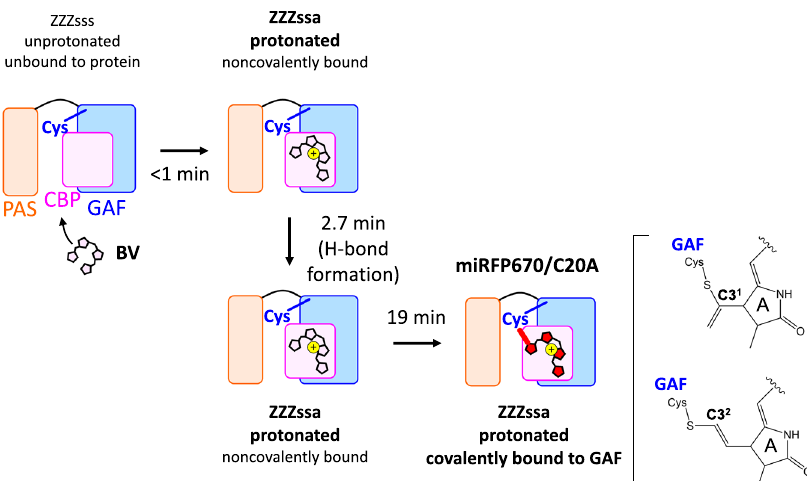
Fig. 3 Biliverdin (BV) incorporation model of miRFP670/C20A. Within 1 min after adding the miRFP670/C20A apoprotein to the biliverdin (BV) solution, BV localization to the chromophore binding pocket (CBP) occurs, binding noncovalently to the protein. BV isomerization and protonation also proceeds within 1 min. In 2.7 min, a hydrogen-bond rearrangement of BV occurs. In 19 min, C – S covalent bond formation between BV and Cys253 in the GAF domain via C3 1 or C3 2 proceeds, completing the BV binding reaction to